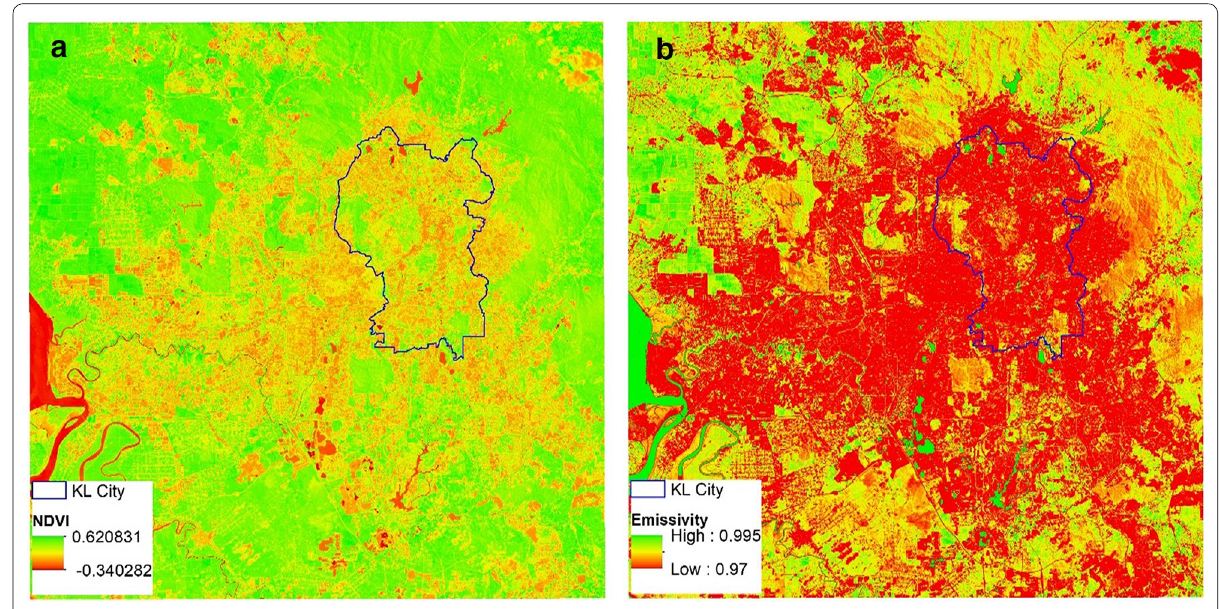
Fig. 2 a Derived NDVI and b land surface emissivity of the study